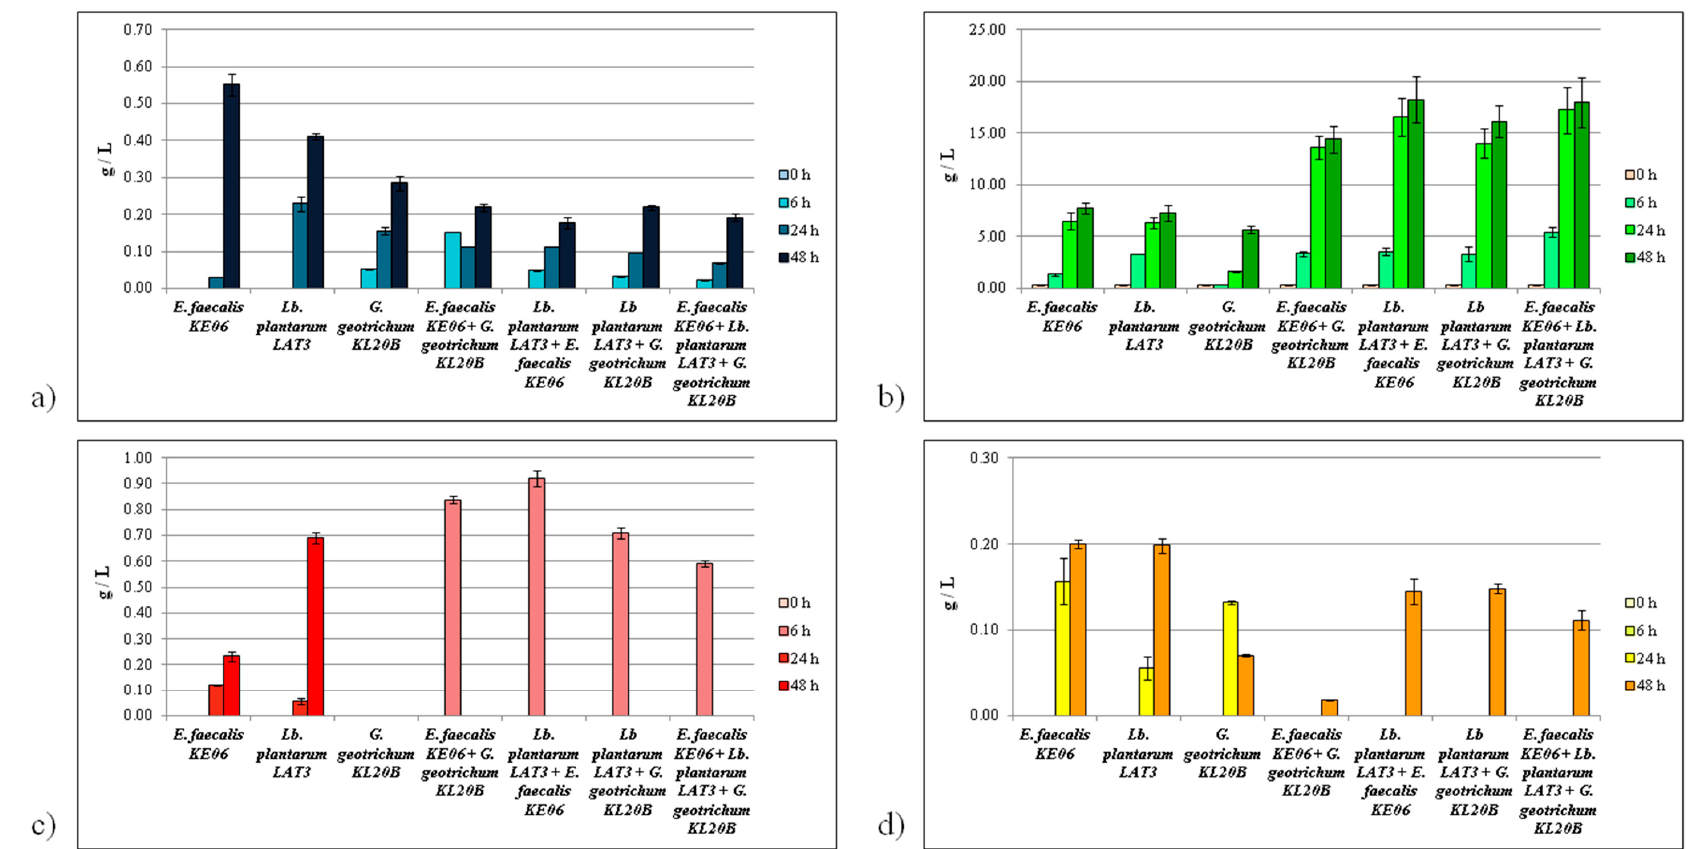
Figure 2. Dynamics of organic acids accumulation during milk fermentation at 28 °C for 48 h: ( a ) Citric acid consumption; ( b ) Lactic acid production; ( c ) Formic acid production; ( d ) Acetic acid production.